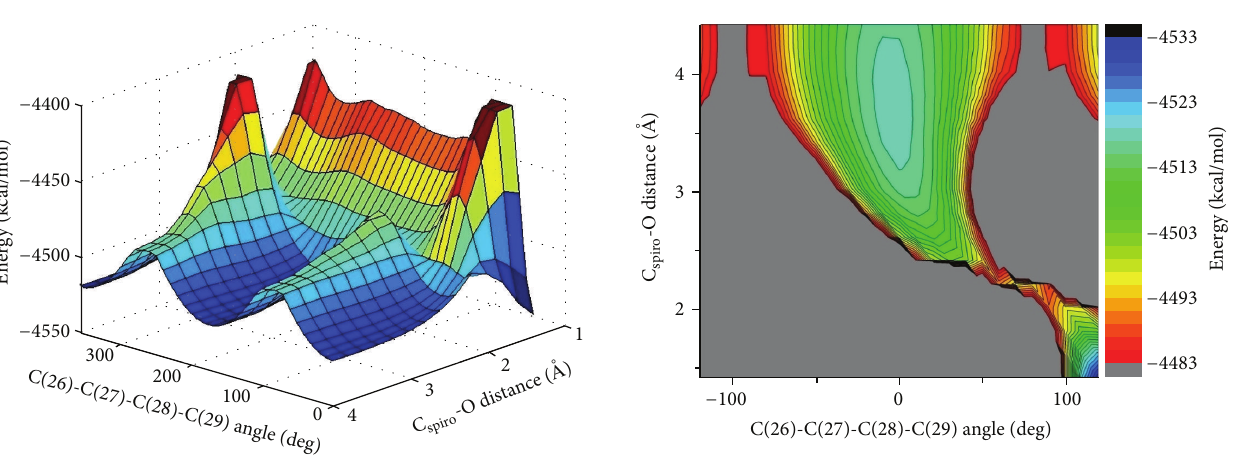
Figure 7: The dependence of the value of N(11)-C(25)-C(26) angle from the length of C C(28)-C(29) (b).